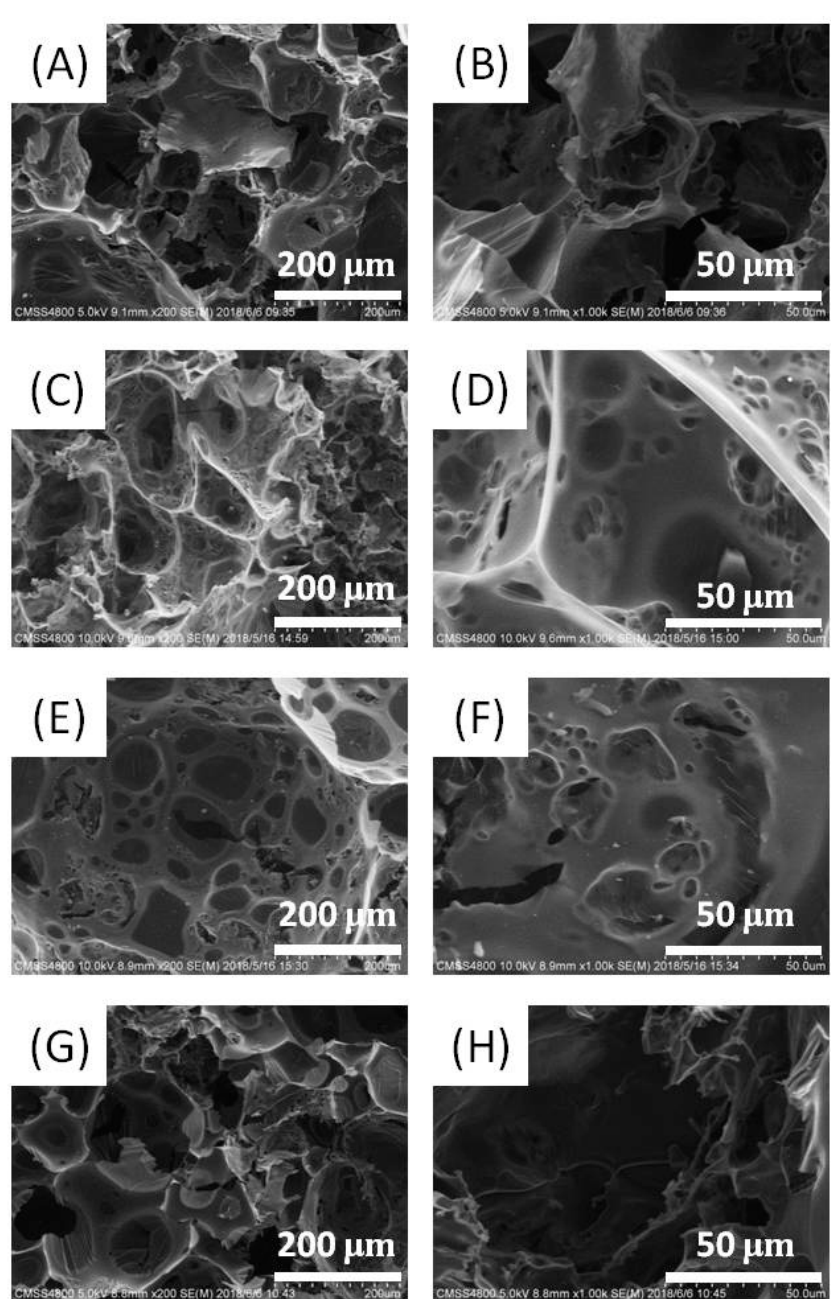
Figure 4. Typical SEM images of porous carbon, ( A , B ) PC-0, ( C , D ) PC-1, ( E , F ) PC-5, ( G , H ) PC-10.